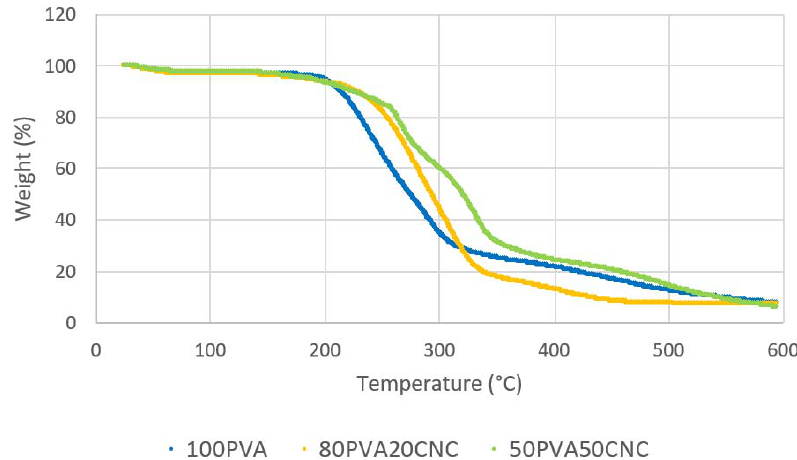
Figure 6. Thermogravimetric analysis (TGA) curves showing weight loss (%) of 100 PVA , 80 PVA 20 CNC and 50 PVA 50 CNC electrospun random mats.